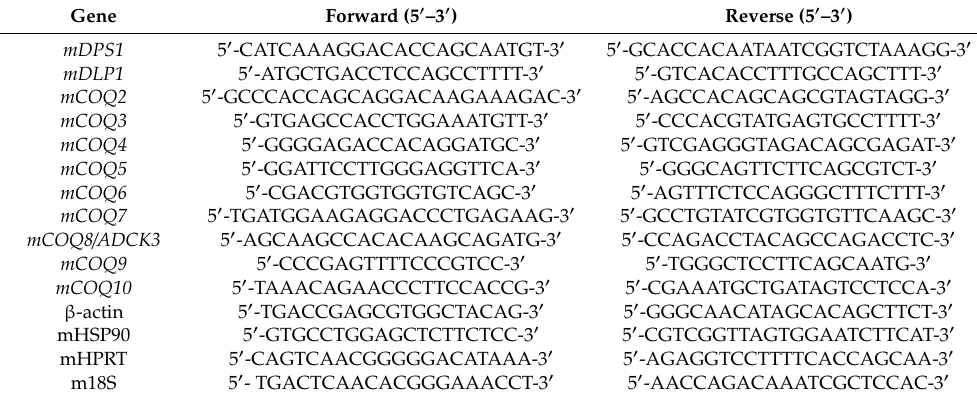
Table 2. Primers used in this